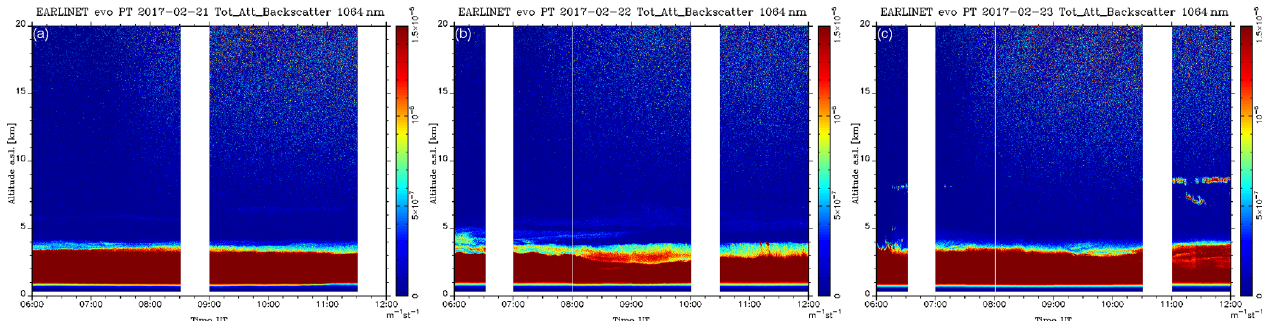
Figure 10. Quicklook images corresponding to the total attenuated backscatter at 1064nm observed with the EARLINET Évora lidar for 21 (a) , 22 (b) and 23 February 2017 (c) nicely show the evolution of this particular dust event (https://quicklooks.earlinet.org/, last access: 12 February 2021). (Blue colours indicate a weak backscattering signal, and yellow and red colours indicate a higher backscattering signal.)